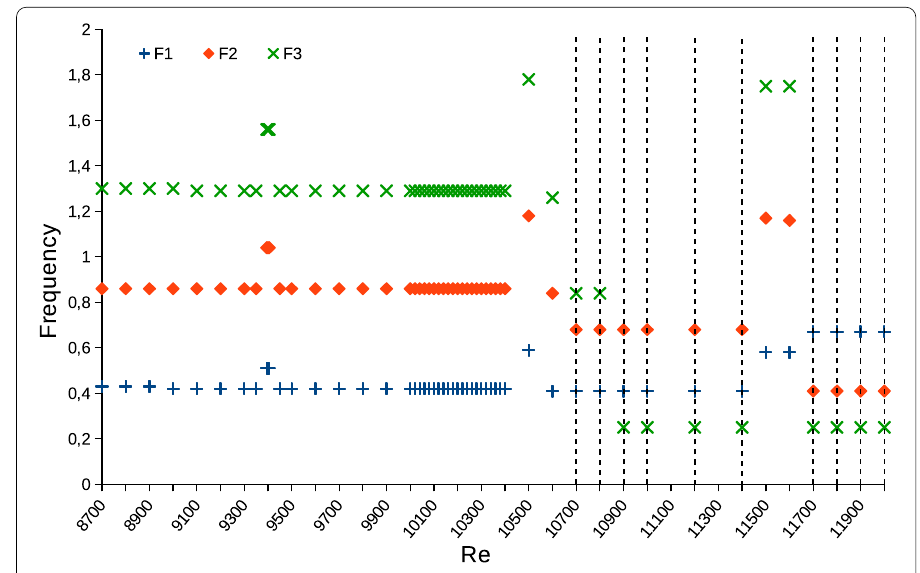
Fig. 5 Frequency variation for Re = [8700 , 12 , 000] for the first three leading frequencies of the vorticity time series at point (0 . 95 , 0 . 95) obtained for the last 50 periods. The dotted lines indicate the presence of multiple dominating peaks in the